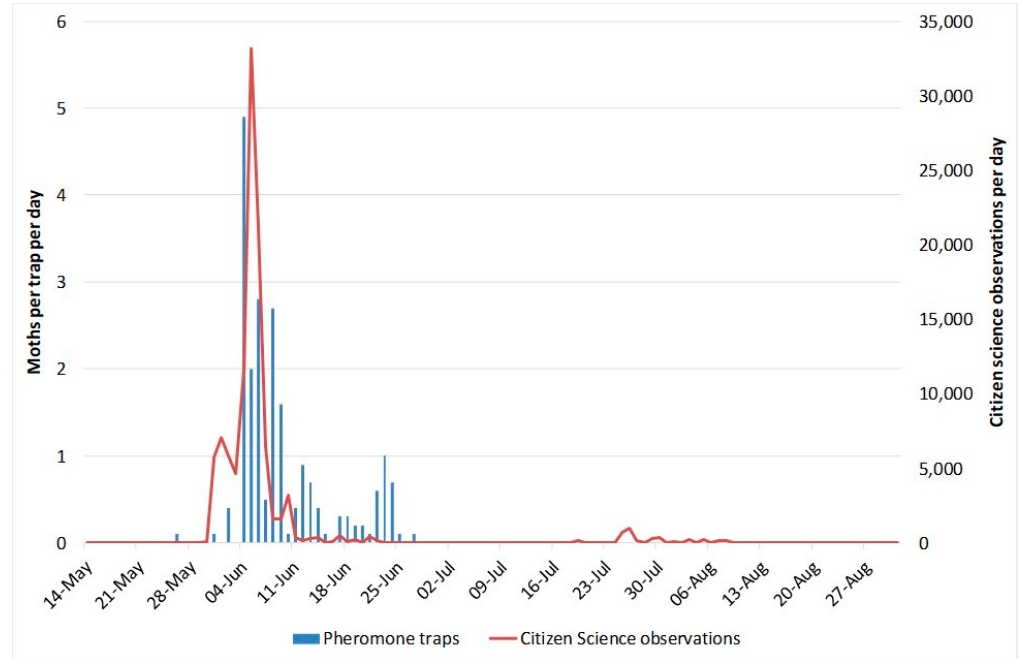
Figure 9. The numbers of moths captured in Trapview pheromone traps per day compared with sightings by citizen scientists per day in the UK in 2016.